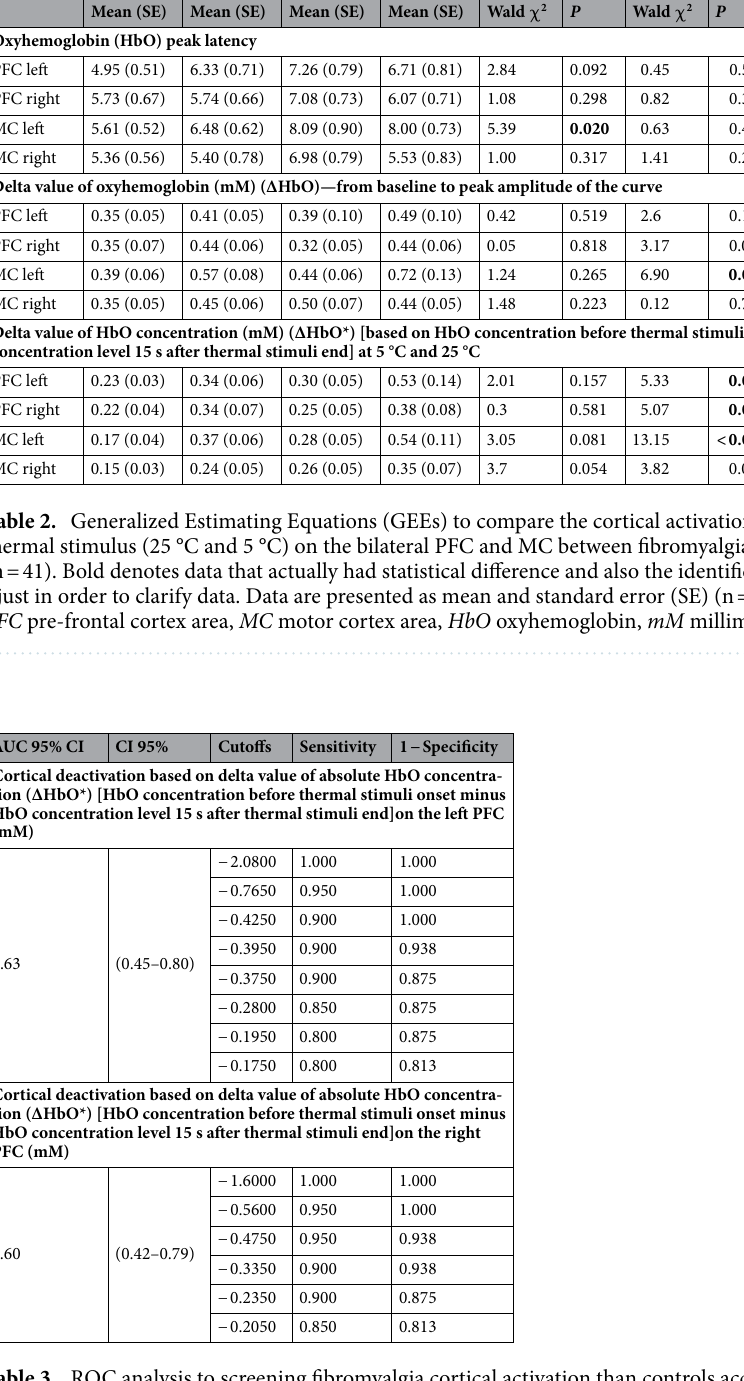
both sides of the PFC. The results of these adjusted multivariate models are presented in Table 5. At the left PFC, a lower Δ-HbO* concentration was positively correlated with disability due to pain and central sensitization symptoms. In contrast, at the right PFC, a lower Δ-HbO* concentration was conversely associated with disability due to pain and central sensitization symptoms.